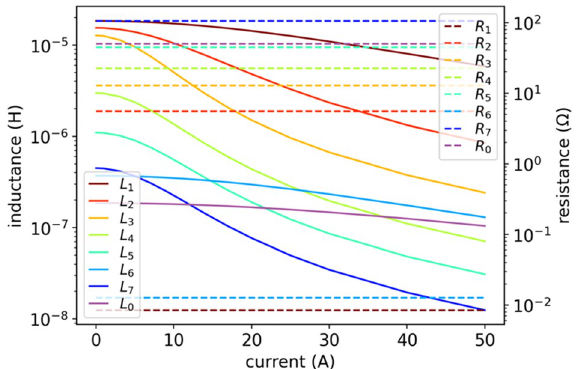
Figure 10. DE results of inductances L ( i ) given by (5) and constant resistances R ( i ) in model (6). Another Results for fitting model (6) with DE optimization, similar courses as in Fig. 9 but now a bit more